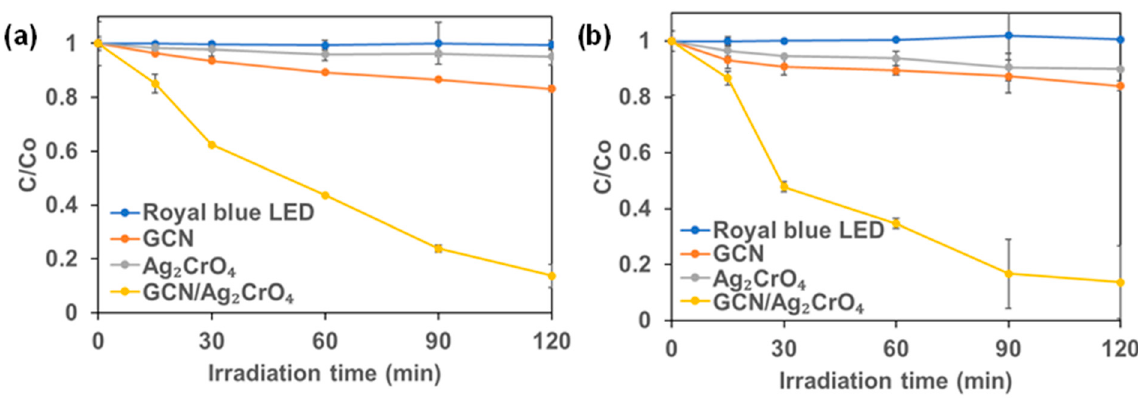
Figure 2. Photocatalytic degradation (royal blue LED irradiation) of Killex R : ( a ) 2,4-D and ( b ) Mecoprop-P.